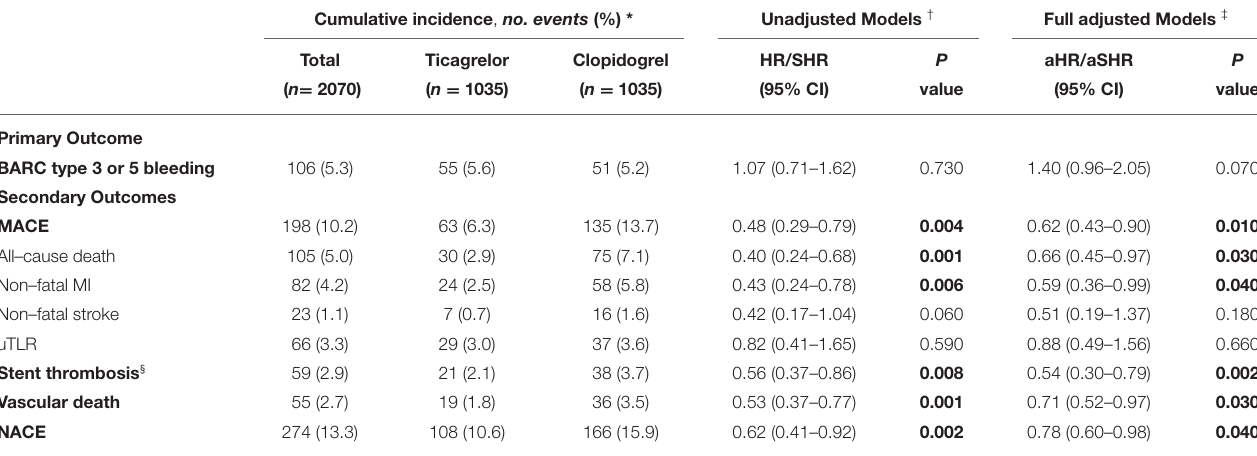
TABLE 4 | Association between the primary and secondary outcomes and use of ticagrelor vs. clopidogrel. Cumulative incidence , no. events (%) * Unadjusted Models